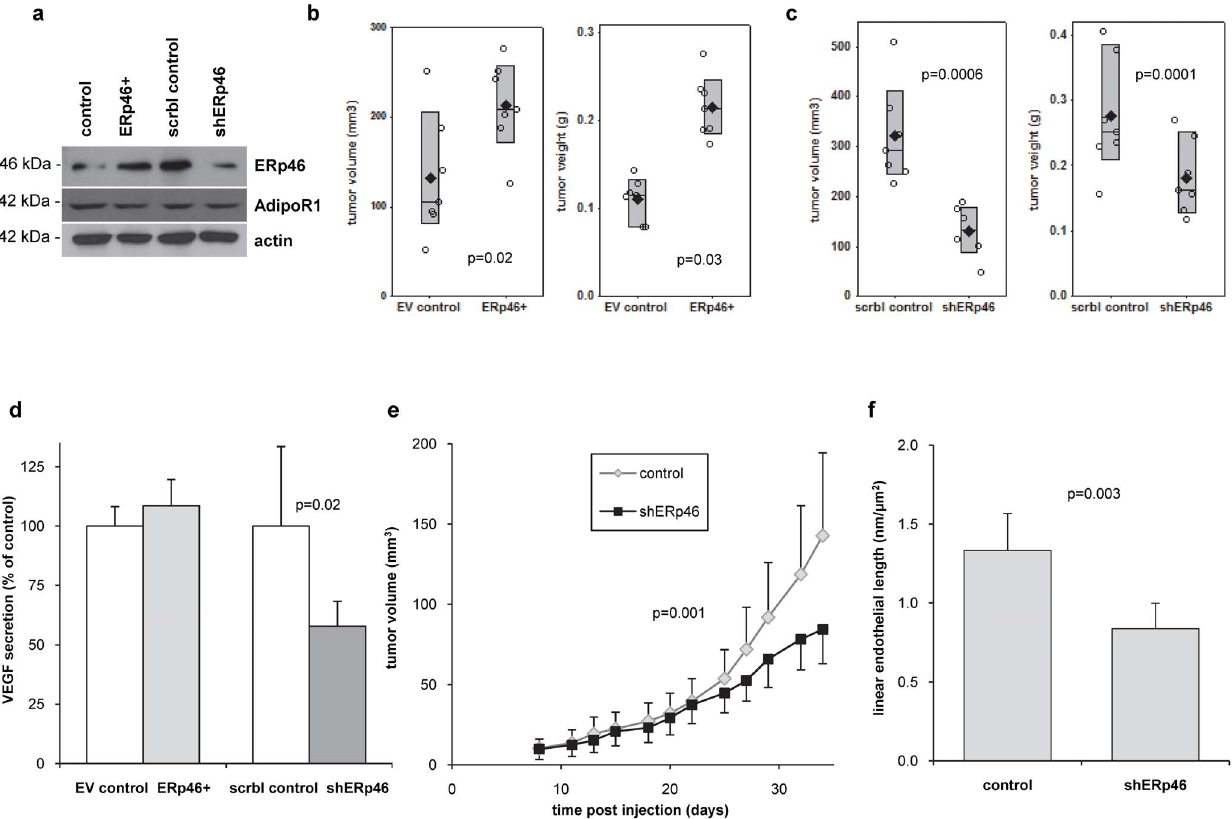
Figure 2. ERp46 supports invivo tumor growth. ( a ) ERp46-manipulated subclones of mouse RCC RAG cells demonstrated a 4-fold increase in ERp46 protein expression in ERp46-overexpressing (ERp46 + ) cells, and a 80% knockdown of ERp46 protein expression in cells stably expressing shRNA specific for ERp46 (shERp46) compared to corresponding control transfected cells. There was no difference in AdipoR1 expression. ERp46 and AdipoR1 were detected by Western blot analysis. The protein expression of b -actin served as loading control. ( b ) In vivo growth of different ERp46- manipulated stable subclones of mouse RCC RAG cells. Tumor volume and weight from mice (n=7/group) injected with ERp46 + -RAG cells is significantly higher than from mice injected with empty vector (EV) control-transfected cells (p=0.02 and 0.03, respectively). Individual values ( # ) and mean ( ¤ ) are shown, the box indicates the 95% confidence interval. ( c ) Tumor volume and weight from mice (n=7/group) subcutaneously injected with shERp46-RAG cells is significantly lower than from mice injected with cells stably transfected with scrambled control shRNA (p=0.0006 and 0.0001, respectively). Individual values ( # ) and mean ( ¤ ) are shown, the box indicates the 95% confidence interval. ( d ) Serum VEGF of the mice subcutaneously injected with ERp46-manipulated RAG cells 35 days after injection (n=7/group). Serum VEGF is significantly lower in shERp46 RAG cell-injected mice compared to corresponding control mice (p=0.02). Data represent mean 6 95% confidence intervals. ( e ) Longitudinal tumor growth of mouse RCC RAG cells in vivo . Mice were subcutaneously injected with 2 6 10 6 RAG cells and treated systemically (intraperitoneally) every second day with shRNA specific for ERp46 (shERp46) or scrambled control shRNA (control) (n=10/group) using the in-vivo jetPEI delivery agent (p=0.001; ANOVA). Data represent mean 6 95% confidence intervals. ( f ) At sacrifice (35 days), the linear endothelial length as determined in CD31- stained subcutaneous tumors is significantly lower (p=0.003) in shERp46-treated RCC RAG cell-injected mice (n=10) compared to mice treated with shControl (n=10). Data represent mean 6 95% confidence